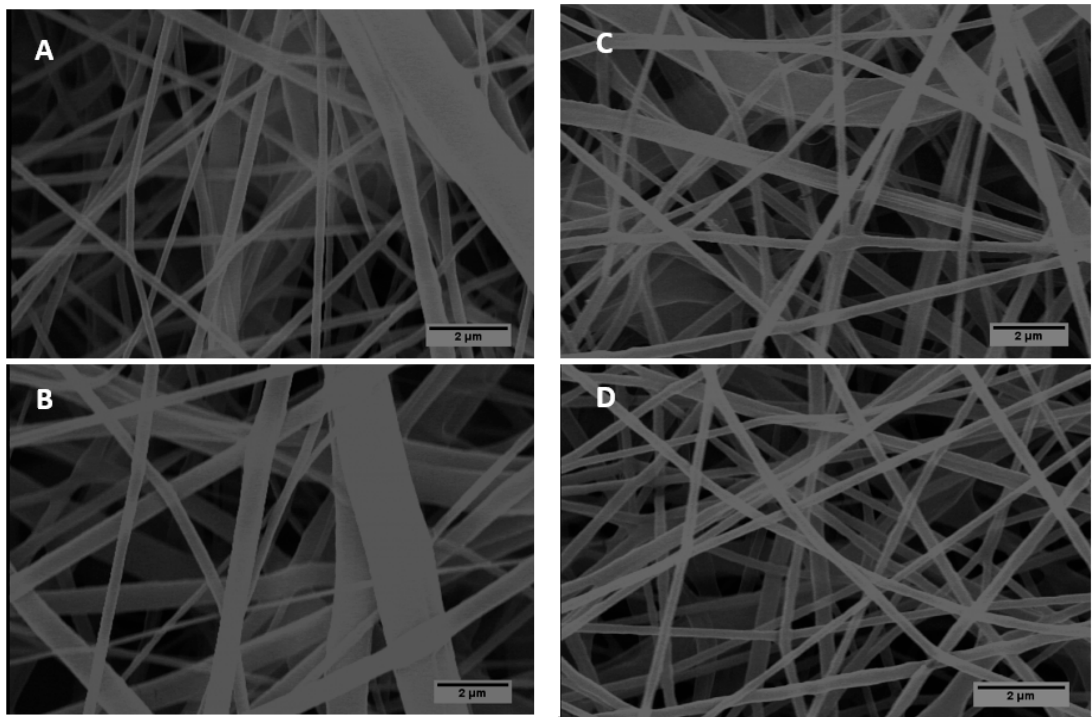
Figure 5. SEM images of the PCL/gelatin/P188 (70:10:20 %w/v) composite nanofibers electrospun at ( A ) 18 kV, ( B ) 20 kV, ( C ) 22 kV, and ( D ) 24 kV voltages. The images were measured at a magnification of ×8000 to ×10,000.